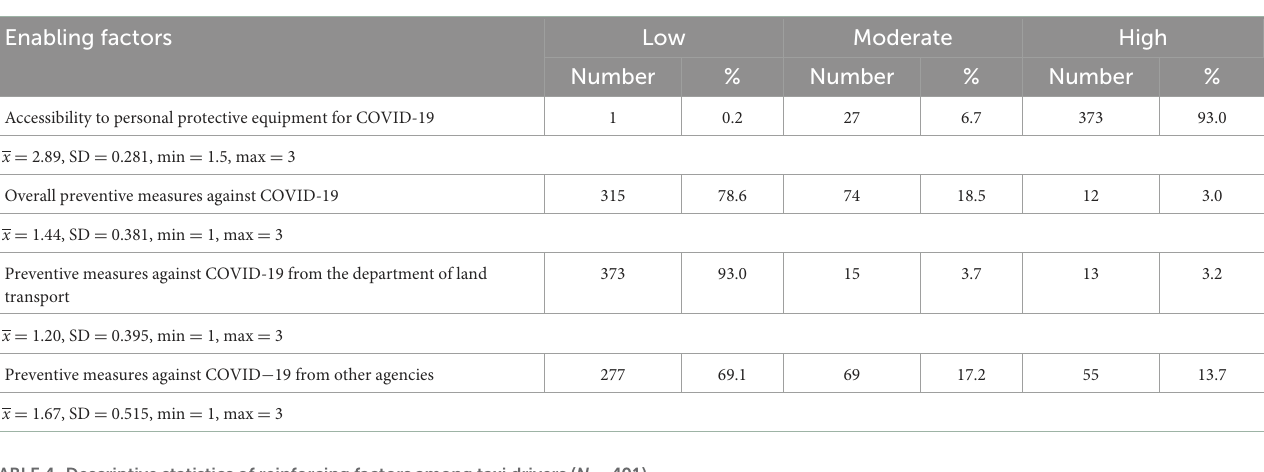
TABLE 4 Descriptive statistics of reinforcing factors among taxi drivers ( N = 401). Reinforcing factors